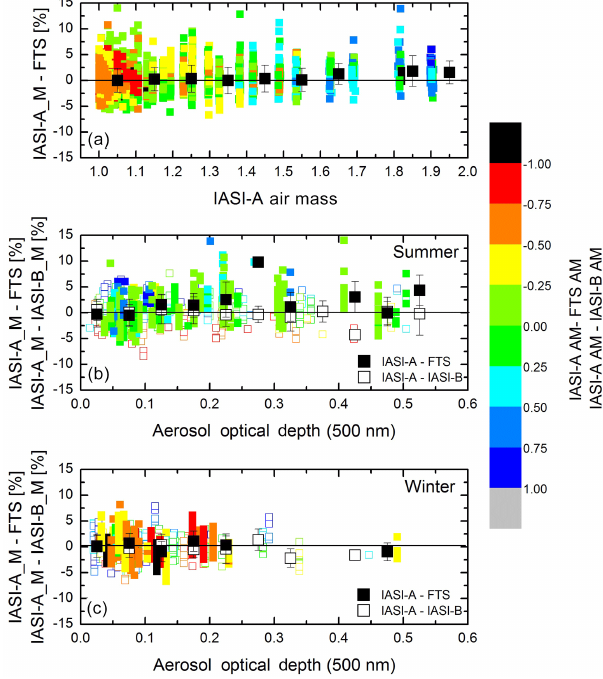
Figure 9. (a) Differences between the O 3 de-trended and de- seasonalised variability time series from IASI-A and FTS (in %) as a function of the IASI-A air mass (AM) plotted as black squares with error bar (median and standard deviation per bins of 0.1 of AM), and simultaneous 2-D plot showing the difference between the IASI-A and FTS AMS. (b) Same as (a) but versus the aerosol optical depth (AOD) at 500nm, recorded at AERONET SCO station during summer. Also, the differences between IASI-A and IASI-B are included. The black and white squares represent the median and standard deviation per bins of 0.025 of AOD for the IASI-A–FTS and IASI-A–IASI-B differences respectively. (c) Same as (b) but during